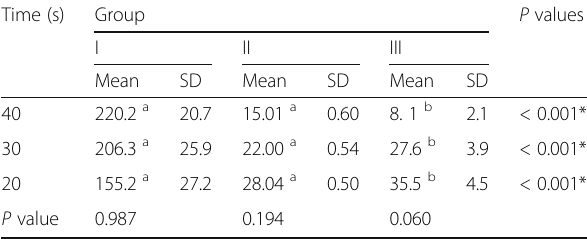
Different letters in the same row are statistically significantly different *Significant at P ≤ 0.05